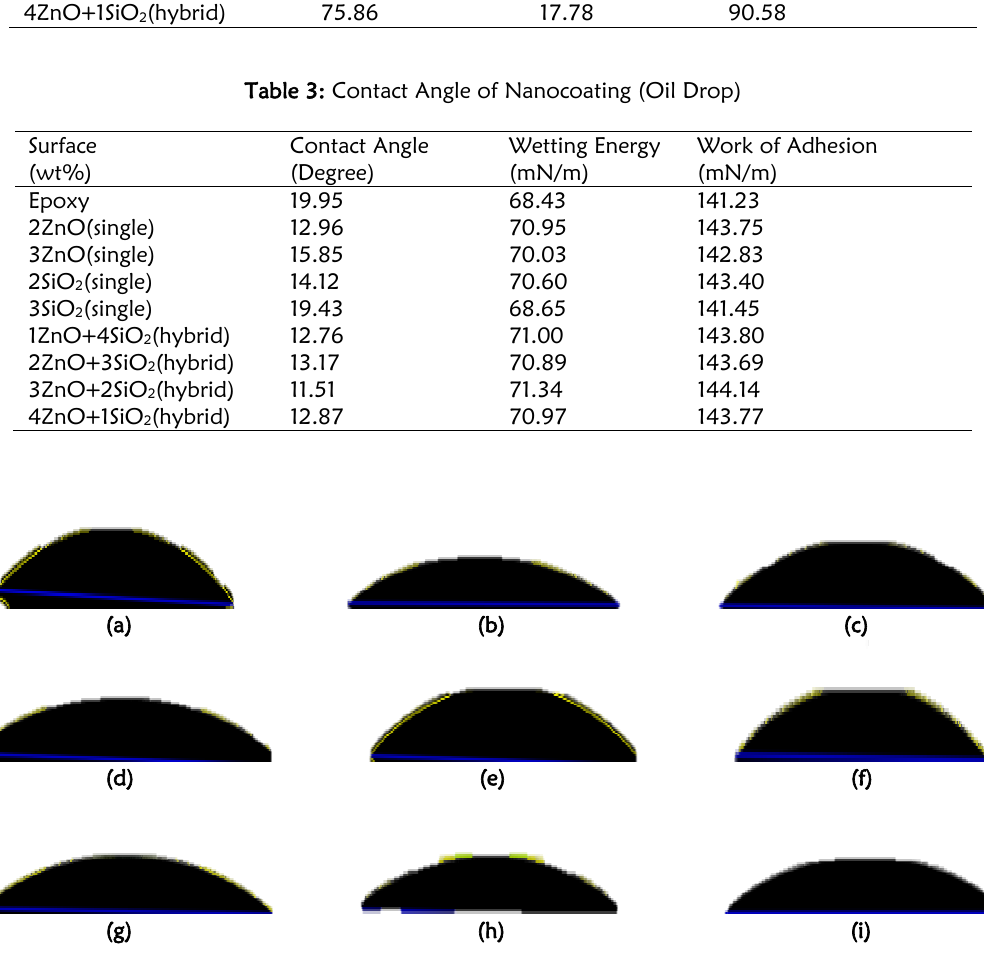
Figure 2: Micrograph images of vacuum oil dropping on nanocoatings: (a) Plain Epoxy; (b) 2wt% ZnO; (c) 3wt% ZnO; (d) 2wt% SiO 2 ; (e) 3wt% SiO 2 ; (f) 1wt% ZnO+4wt% SiO 2 ; (g) 2wt% ZnO+3wt% SiO 2 ; (h) 3wt% ZnO+2wt% SiO 2 ; (i) 4wt% ZnO+1wt% SiO